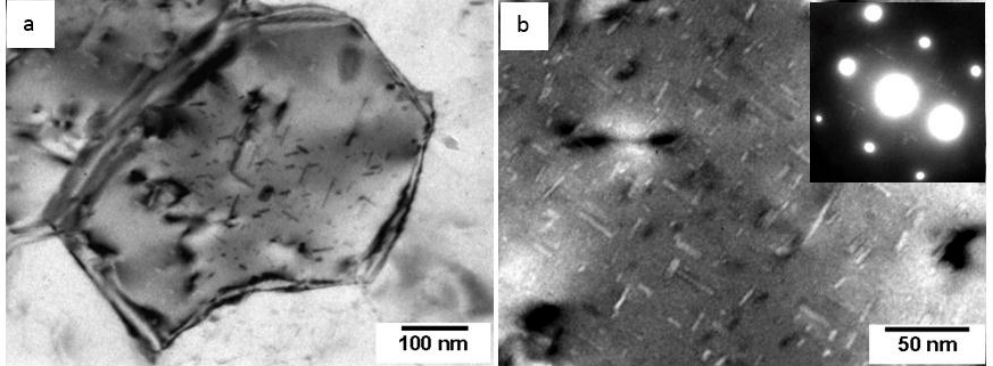
Figure 6. Strengthening second-phase precipitates present in the Al matrix of the ECAP-C processed alloy artificially aged at 170 °C for 12 h: ( a ) bright field TEM image; and ( b ) bright field TEM image and corresponding SAED patterns (the crystal is close to the [001] zone axis